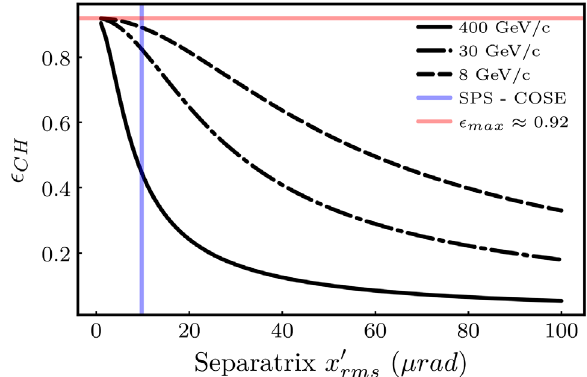
22. Channelling efficiency for the crystal used in the SPS test as a function of the separatrix RMS angular spread. The dependence has been parametrized for three different beam energy: 8, 30, and 400 GeV =